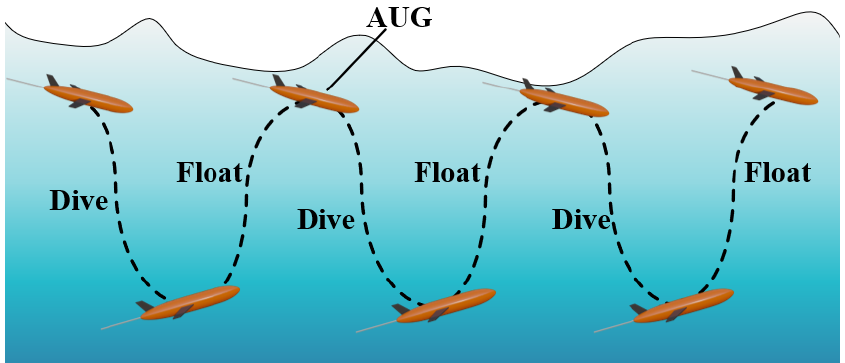
Figure 1. Diagram of the traveling mode of the AUG.